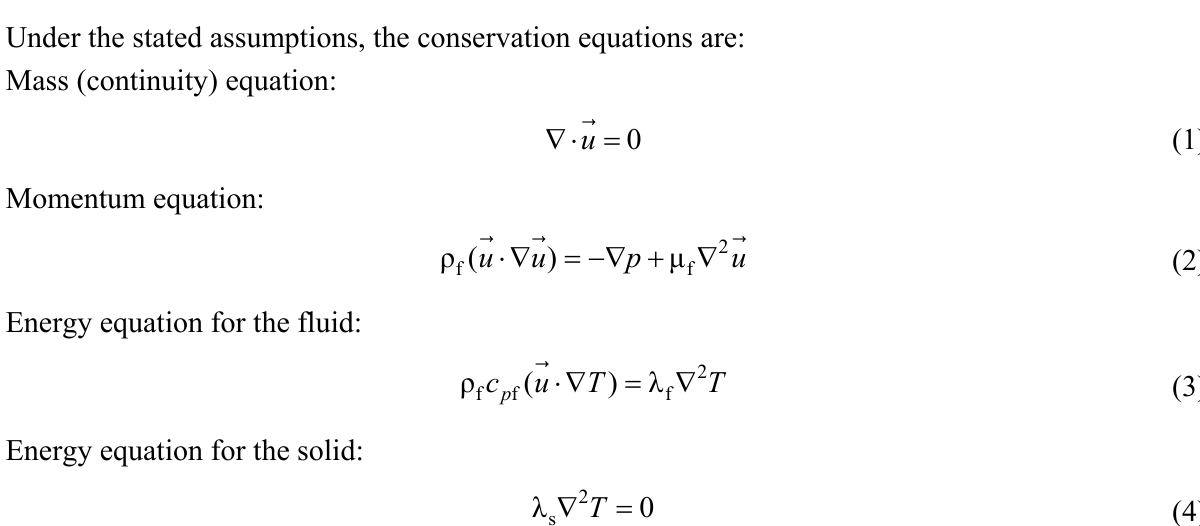
Figure 1. Physical model of the laser-induced heating effect. The heat source is a heat flux with Gaussian profile as shown in Equation (8). The Gaussian profile is determined by P , α and d . In our case, α = 65% and P and d range from 0.5–10 mW and 1–5 μ m, respectively. The mesh within a 10 μm diameter spherical space around the heat source center was refined up to 0.02 μm